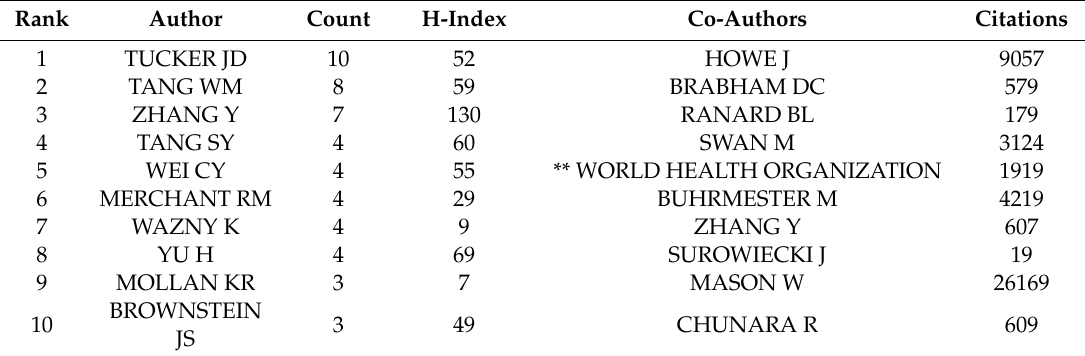
Table 3. Top 10 productive authors and co-authors.